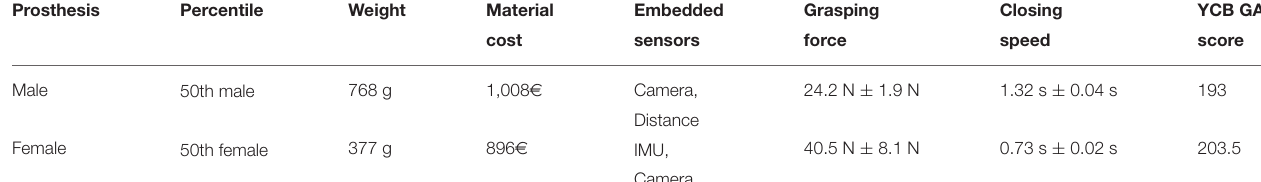
TABLE 3 | Key characteristics of the male and female KIT prosthetic hands. Prosthesis